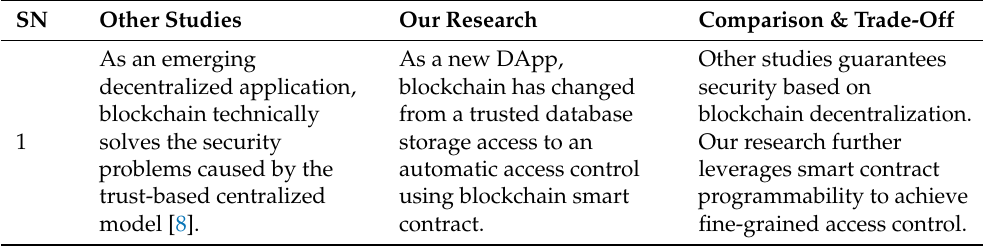
Table 2. Other studies vs. our